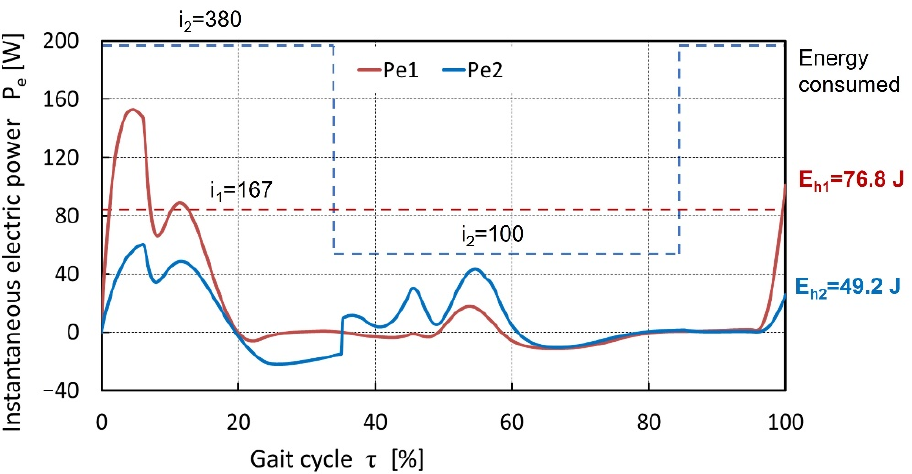
Figure 20. Comparison of the energy consumption of a system with a constant and variable ratio.